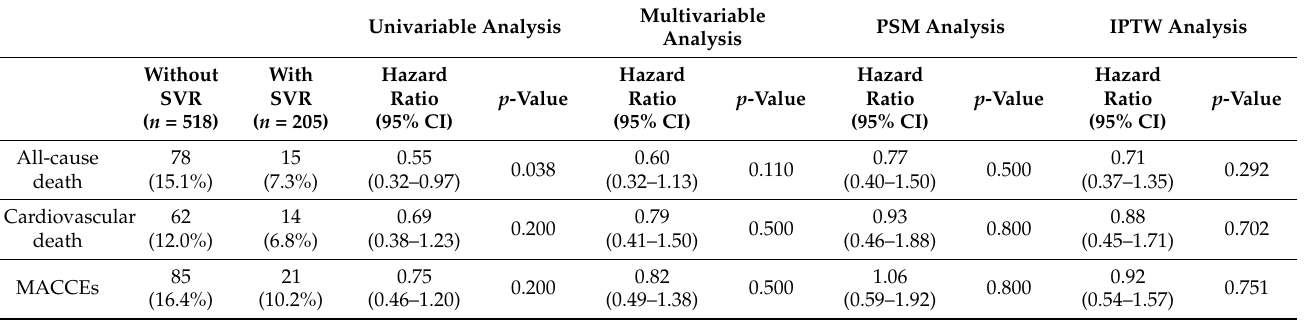
Table 2. Outcomes in the whole cohort and according to SVR group.